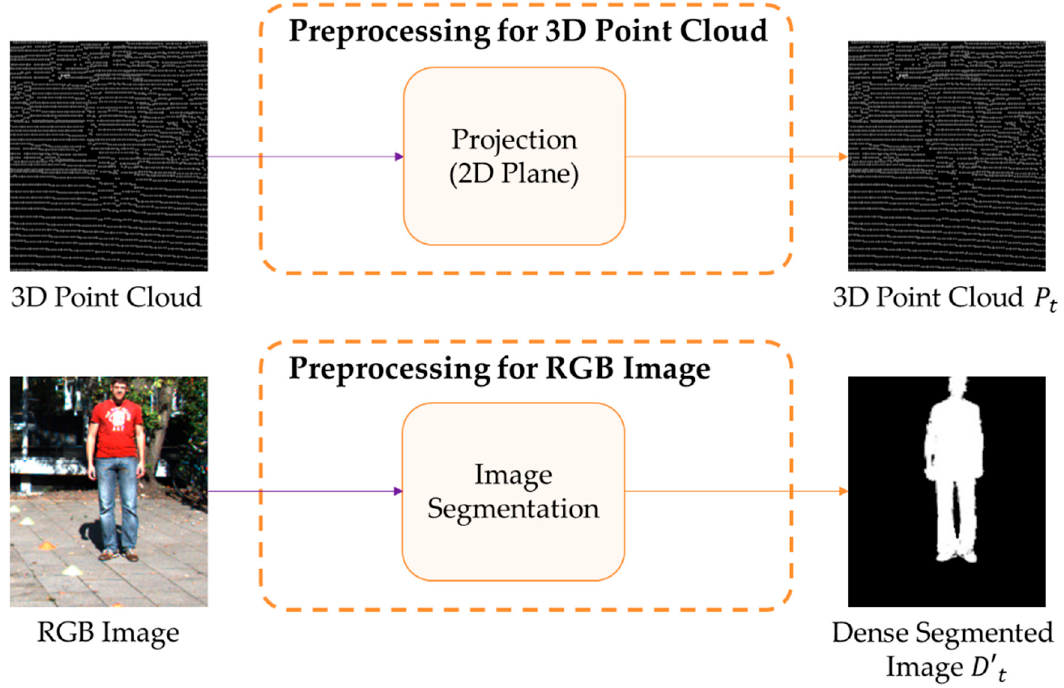
Figure 3. Preprocessing the collected 3D point cloud and collected RGB